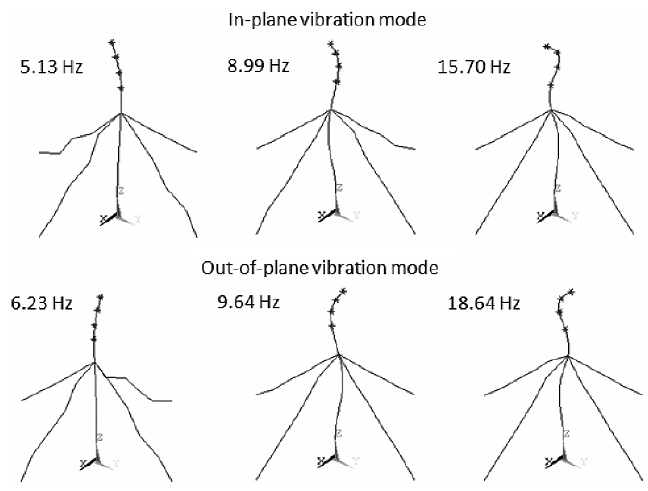
Fig. 7. Pole-leading vibration modes of the simplified steel